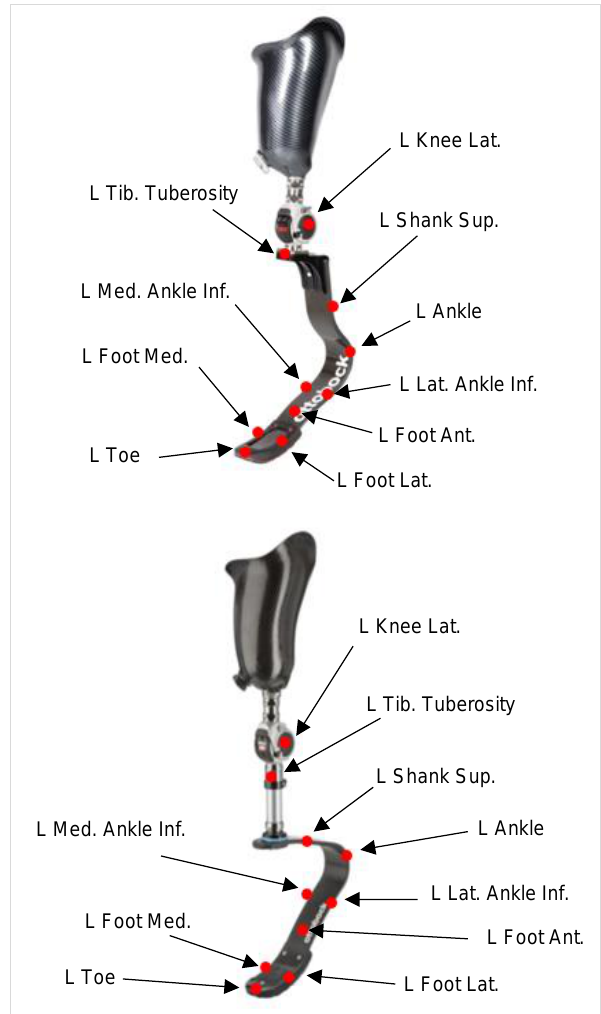
Figure 2: Marker placements on the 1E90 Sprinter foot (Top) and 1E91 Runner foot (Bottom) (Figure adapted from Ottobock 11,12 ). Not pictured: “heel” marker placed posteriorly at the most acute radius of the